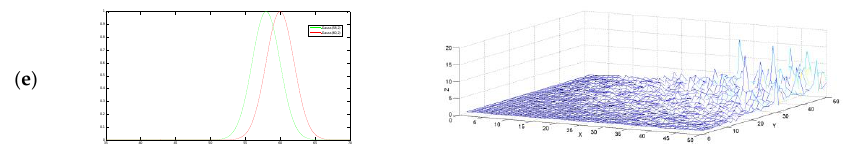
Figure 2. Five experiments are shown in subfigures ( a – e ), respectively. As for each experiment, the left subfigure shows a paired of Gaussian distributions, which are utilized to generate DN values of two over-segments, respectively; the right one is the distribution of the merging probability over the numbers of pixels within the two over-segments.